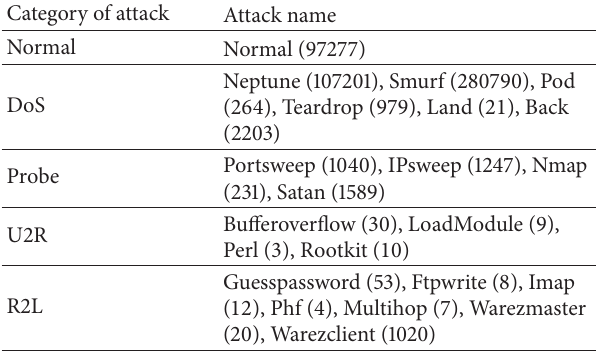
Table 2: Sample size in 10% KDDCUP dataset.